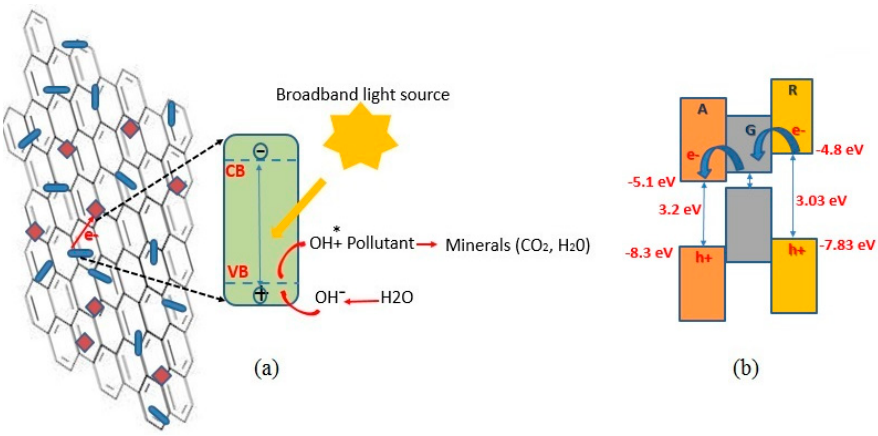
Figure 1. ( a ) Structure and photocatalytic mechanism in graphene-TiO 2 thin films. The rectangular and rod-like features on graphene illustrate anatase and rutile TiO 2 , respectively; ( b ) energy band alignment of graphene-TiO 2 . A, R and G denote anatase, rutile and graphene, respectively.